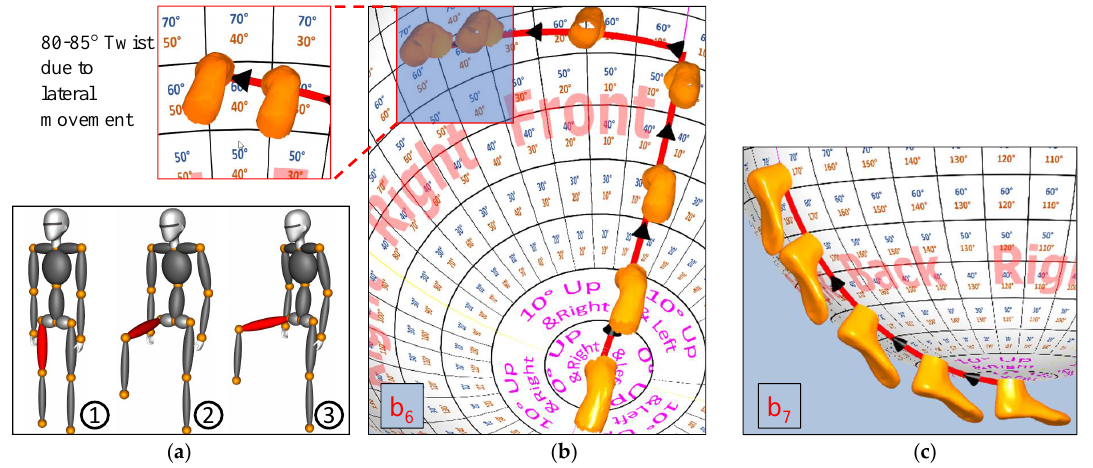
Figure 8. ( a ) Reconstruction of the right upper leg range of motion (ROM) movement of TotalCapture on a 3D avatar ( b ) Visualization of the movement on a Motion-sphere for b 6 ( c ) Visualization of b 7